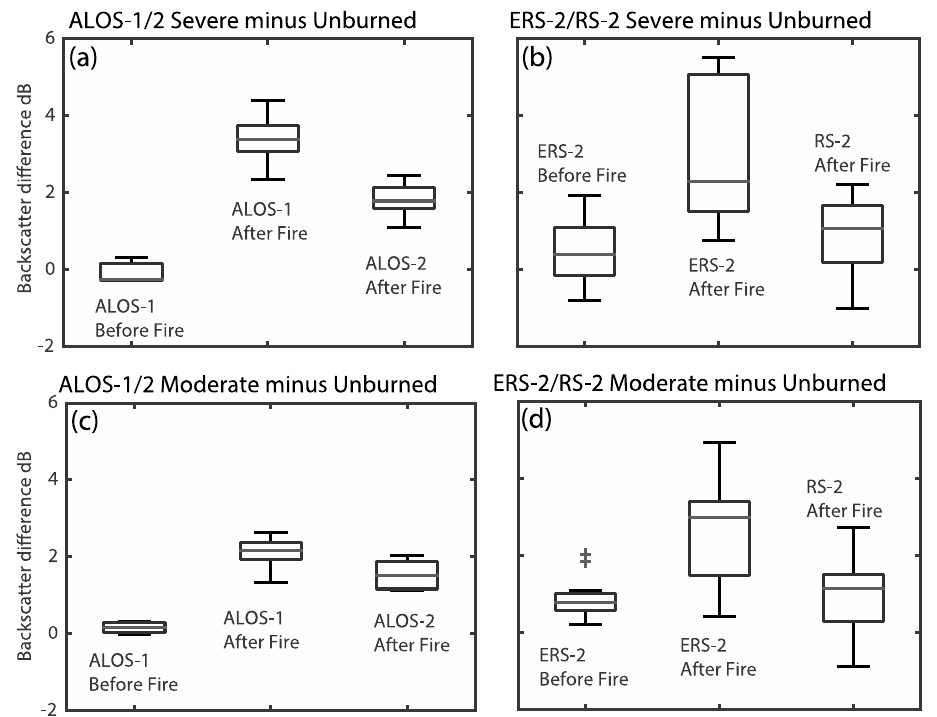
Figure 8. Statistical summary of the backscatter differences. For each box, the central line is the median, the upper and lower edges of the box are the 25th and 75th percentiles, the whiskers represent the minimum and maximum values, and the plus symbols mark the outliers. ( a , b ) present ALOS-1 / 2 and ERS-2 / RS-2 backscatter di ff erence between severe and unburned area, ( c , d ) present the ALOS-1 / 2 and ERS-2 / RS-2 backscatter di ff erence between moderate and unburned